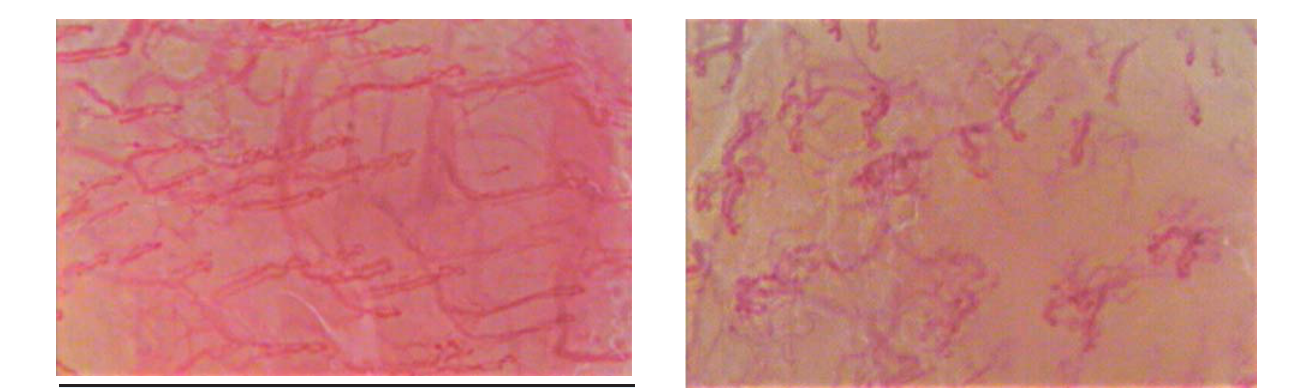
Figure 1. Oral microcirculation of patients affected by hypertension in treatment with antihypertensive drugs. A picture particularly dense in capillaries alternating “forked” capillaries and tortuous